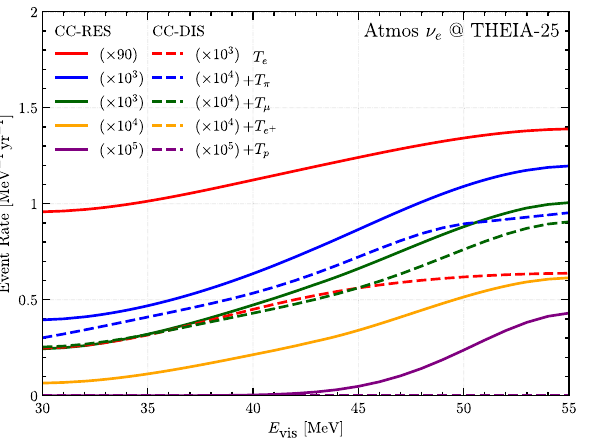
Fig. 3 The atmospheric ν e (left) and ¯ ν e (right) background event rate spectrum from CC-RES (solid) and CC-DIS (dashed) interactions as a function of the visible energy E vis at THEIA-25. With energy deposits from the primary electron ( T e , red), charged π + ( + T π , blue), μ + ( + T μ , green), the Michel electron ( + T e + , yellow), and proton ( + T p , purple) gradually added up, the ν e event spectrum moves out of the IBD energy